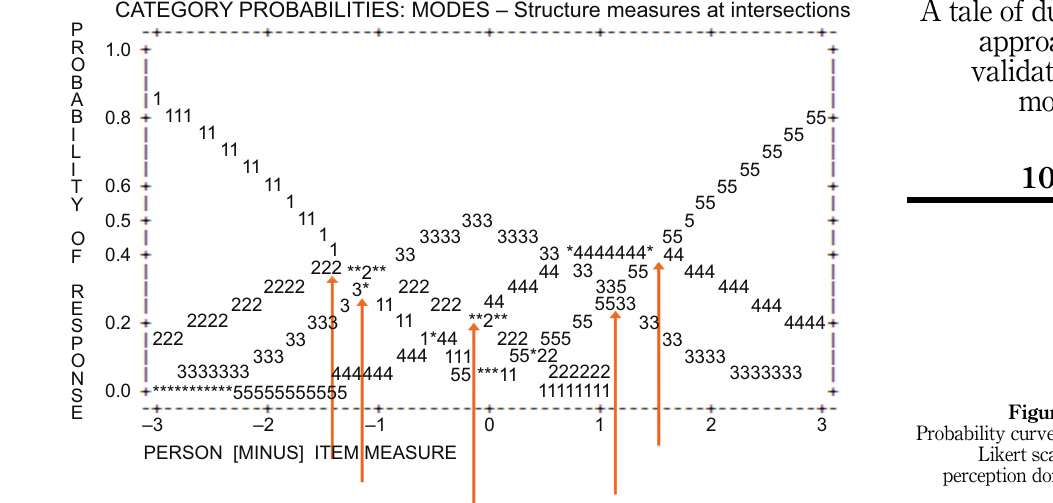
Figure 1. Probability curves